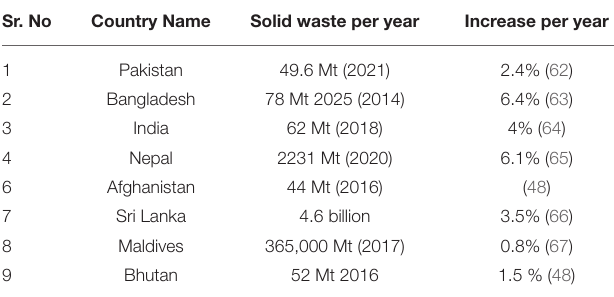
TABLE 1 | South Asian Countries waste Production per year. Sr.